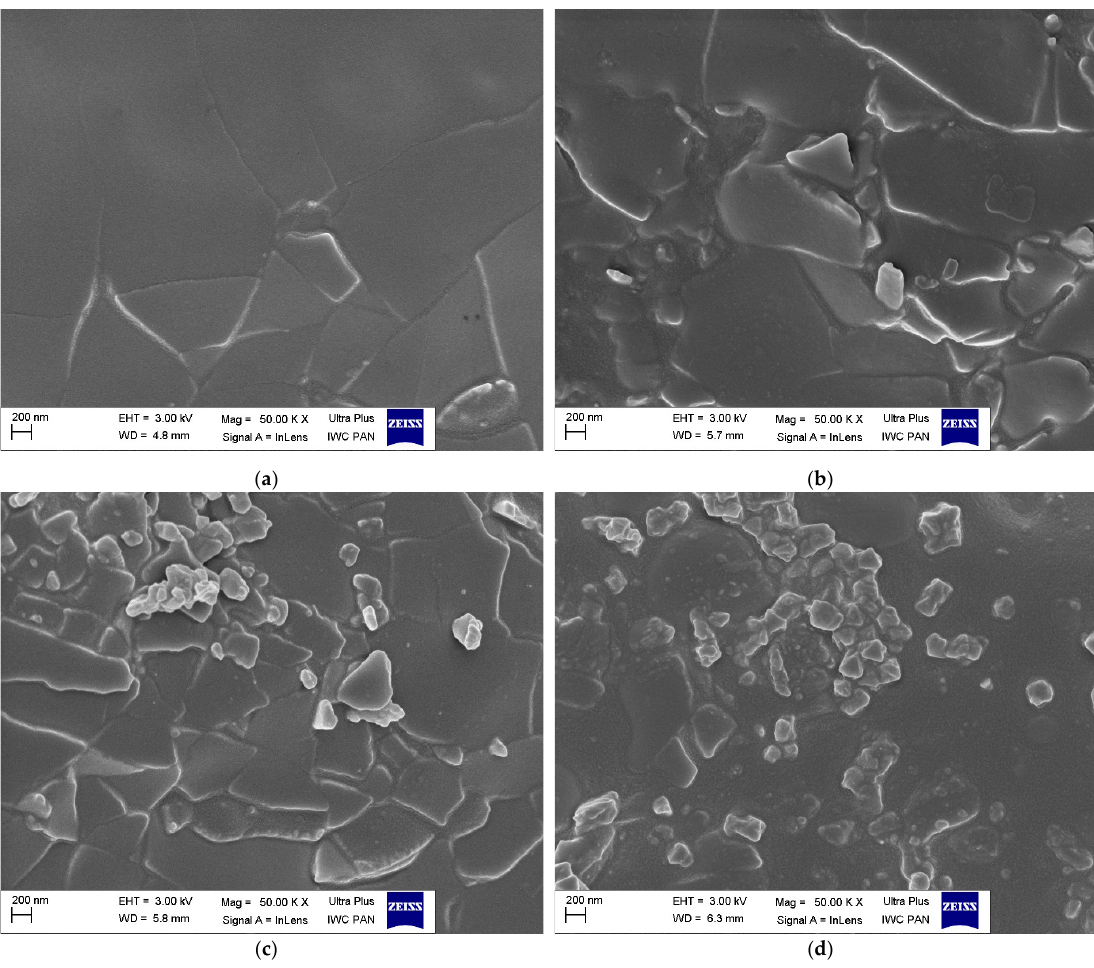
Figure 7. SEM images of NR vulcanizates filled with different amounts of ground eggshells: ( a ) 10ES; ( b ) 20ES; ( c ) 30 ES; ( d ) 40ES.